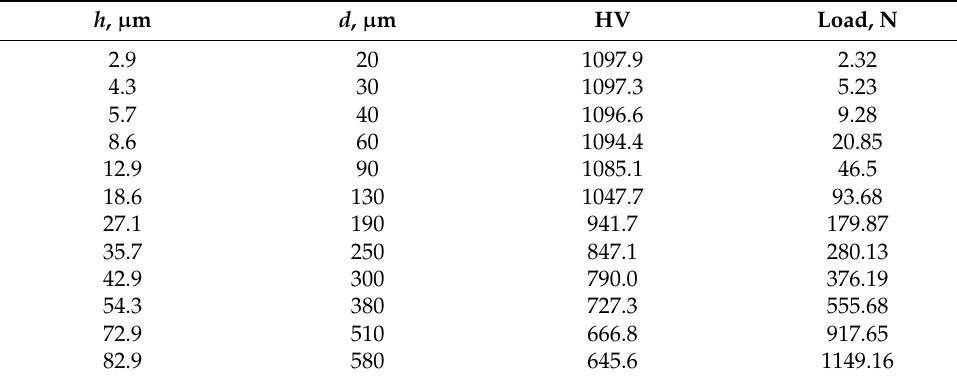
Table 3. Loads belonging to indentation depths.